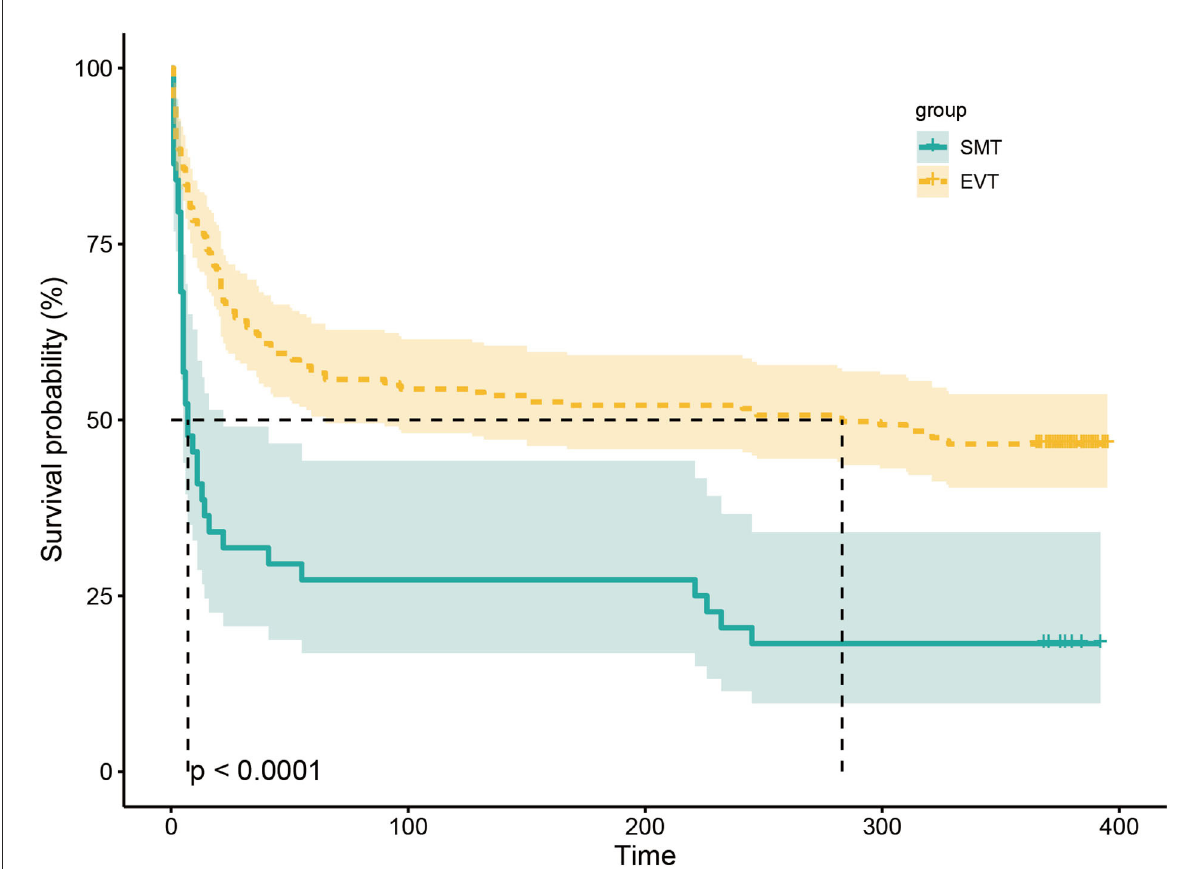
FIGURE2 Kaplan–Meier curve estimates of the probability of death during the 1-year follow-up. The probability of death during the 1-year follow-up in SMT and EVT groups. SMT, standard medical treatment; EVT, endovascular treatment.